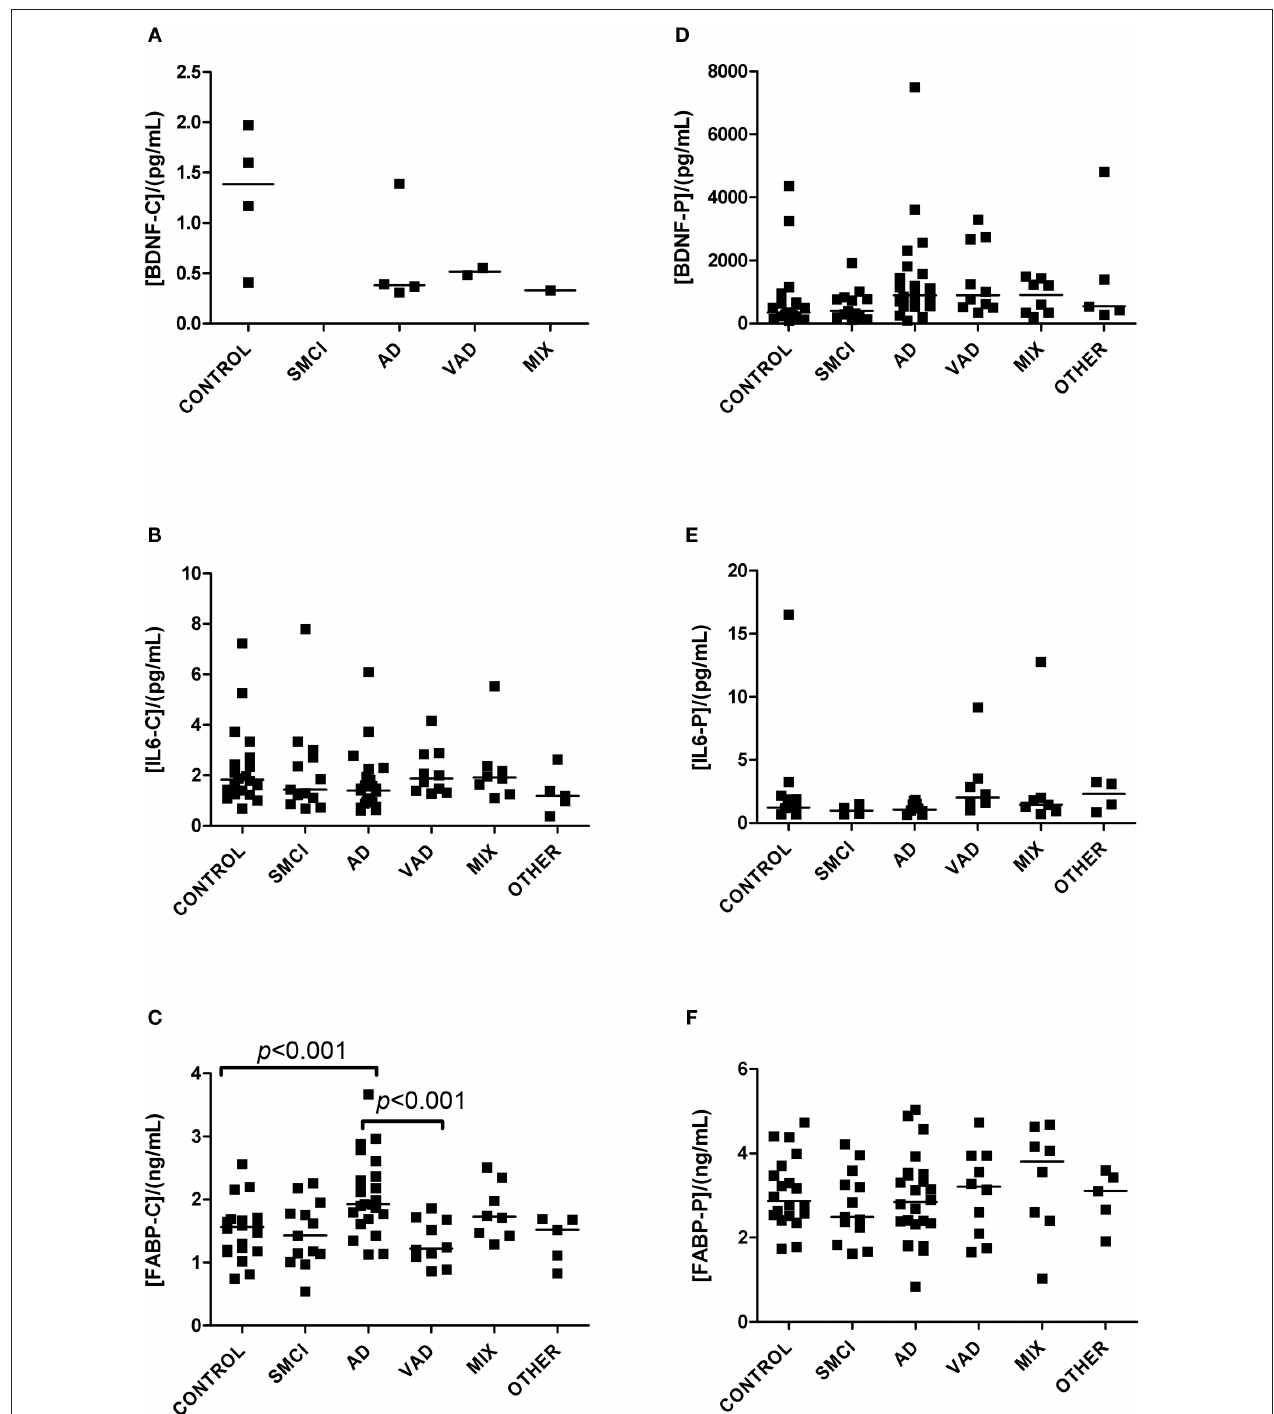
FIguRE 1 | Levels of analytes in plasma and CSF. (A–C) Show values obtained in CSF, and (D–F) display values obtained in plasma. Significant differences between diagnostic groups are shown by brackets. Straight lines indicate median